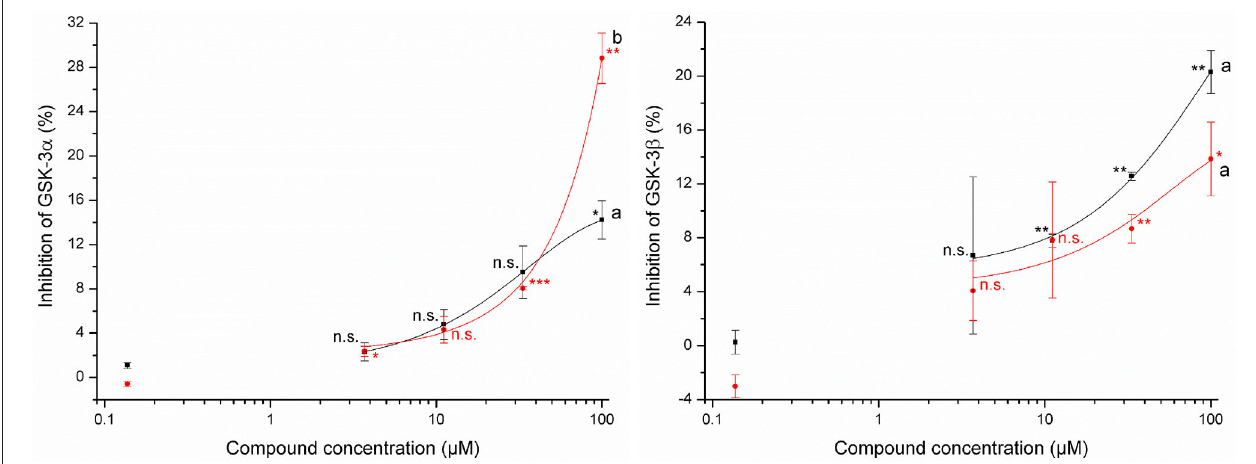
FIGURE 3 | Effects of 3-allyl-4-hydroxythiazolidine-2-thione (allyl HTT, black square) and 4-hydroxy-3-(4-(methylsulfinyl)butyl)thiazolidine-2-thione (4-MSOB HTT, red circle) on the inhibition of glycogen synthase kinases-3 α (left) and glycogen synthase kinases-3 β (right) by using Z’-LYTE assay ( n = 2, data shown as mean ± SD) with different letters for significant different results between both HTTs at 100 µ M ( t -test, p < 0.05). Stars report significant differences of means as tested by t -test of the concentration level compared to the standard with 0.14 µ M at different significance levels: * p ≤ 0.05, ** p ≤ 0.01, *** p ≤ 0.001, and n.s. (not significant, p >